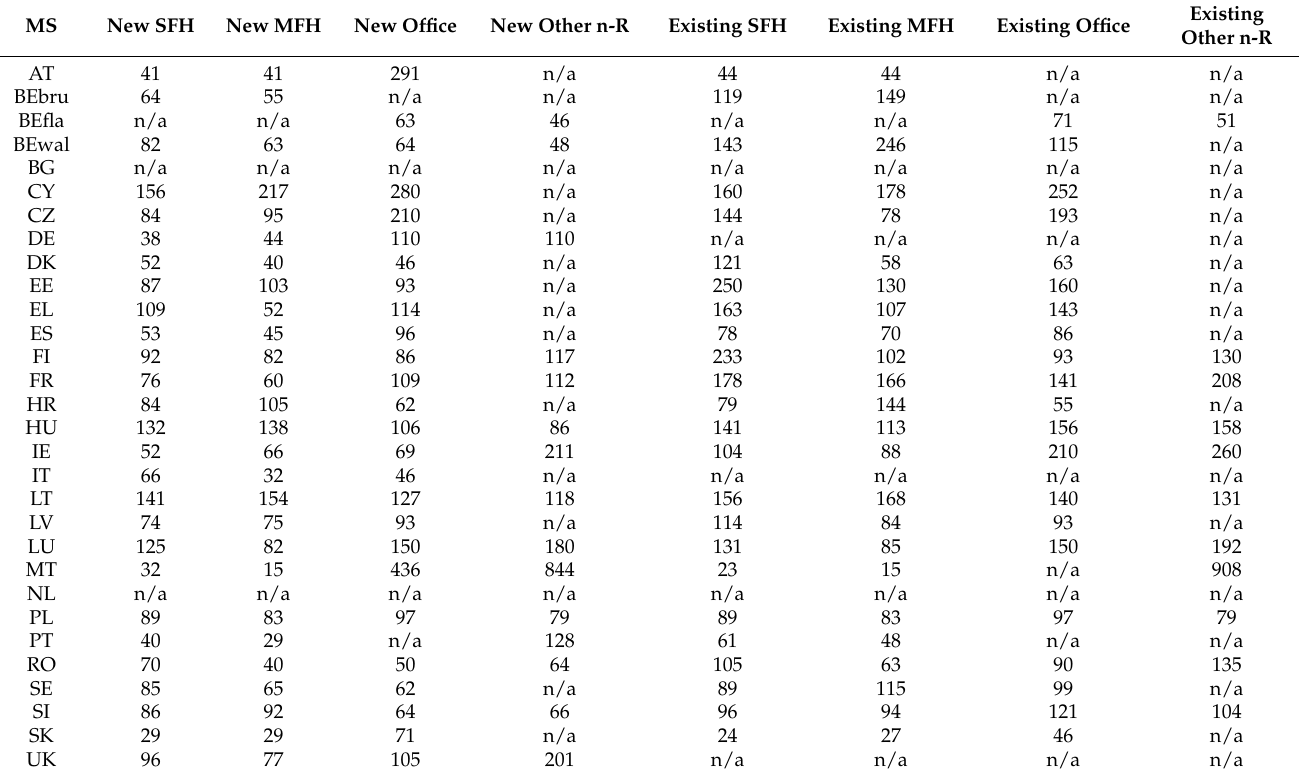
Table 7. Consolidated version of cost-optimal levels in kWh/m 2 y (considering both 2020 and 2013